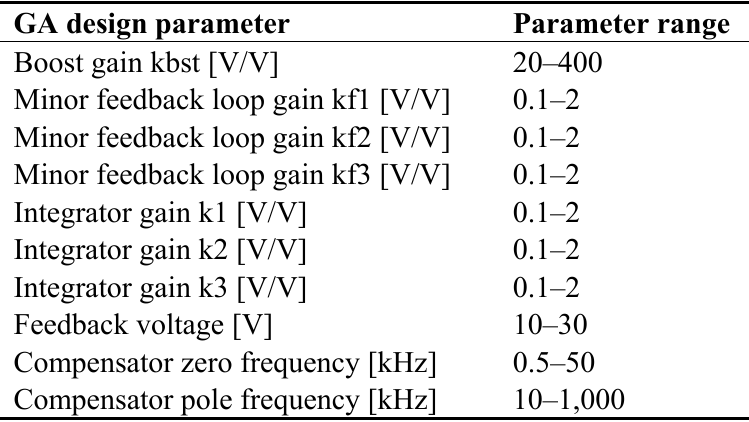
Table 2. Design Parameters for the Genetic